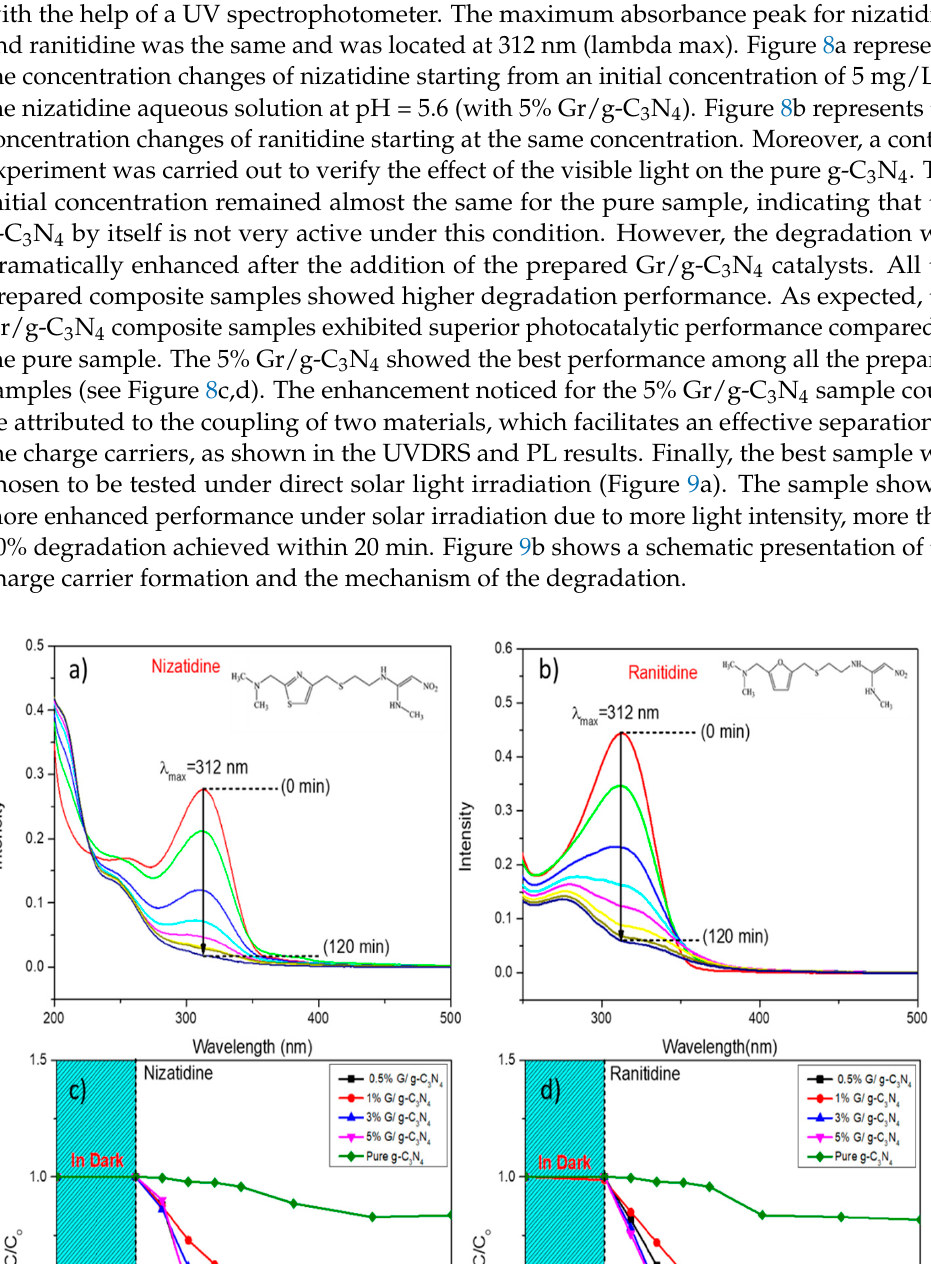
Figure 9. ( a ) C/C o Plots for nizatidine and ranitidine under UV and Solar irradiation. ( b ) the photo- catalytic mechanism under solar light. 3. Materials and Methods 3.1. Materials